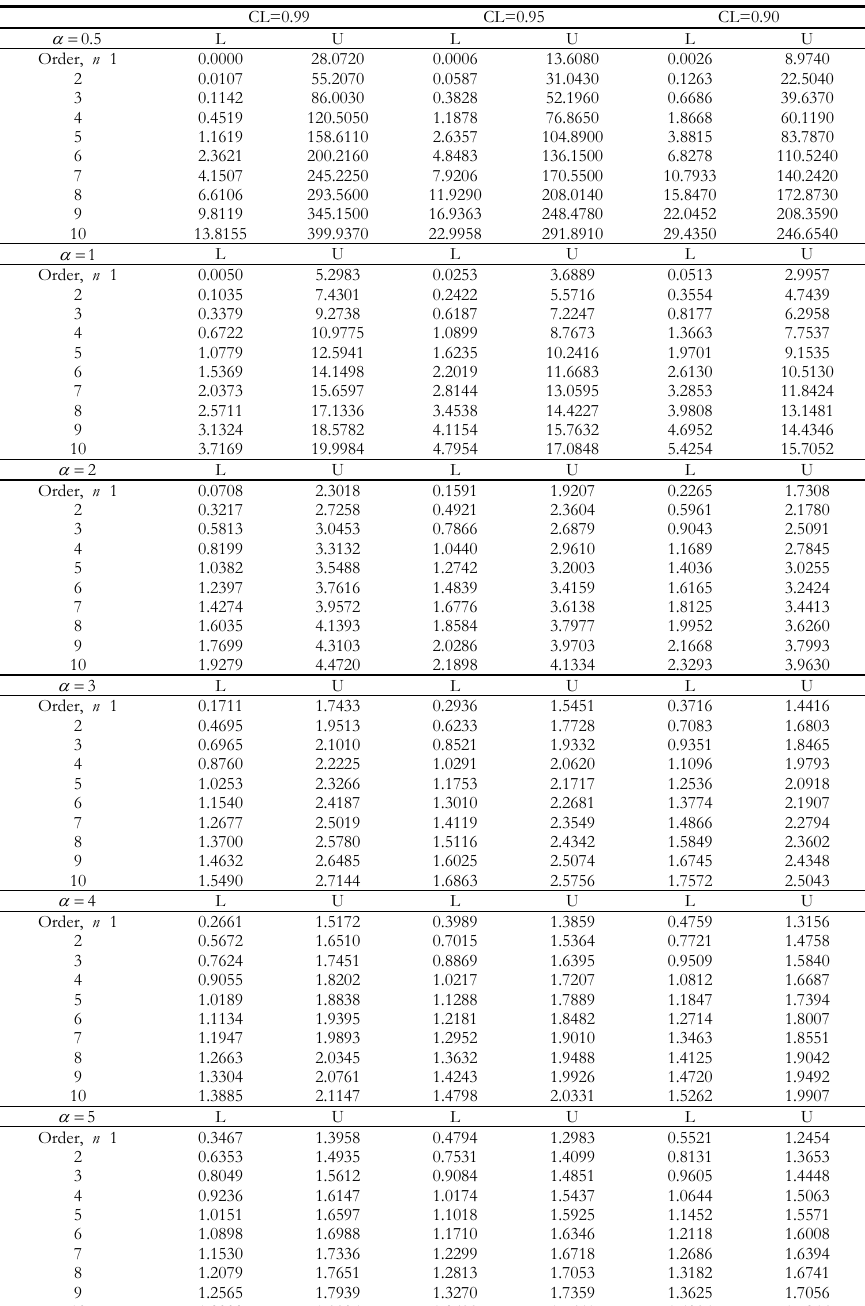
Confidence interval for n th upper record of Weibull family